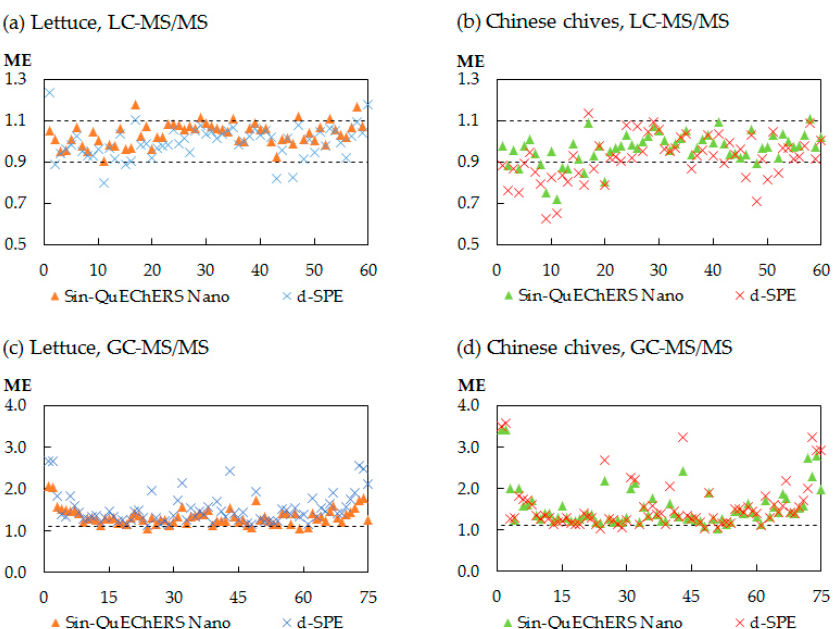
Figure 4. Comparison of the matrix e ff ects (MEs) for all pesticides in lettuce and Chinese chives using the di ff erent cleanup procedures. ( a ) pesticides in lettuce analyzed by LC–MS / MS, ( b ) pesticides in Chinese chives analyzed by LC–MS / MS, ( c ) pesticides in lettuce analyzed by GC–MS / MS and ( d ) pesticides in Chinese chives analyzed by GC–MS /